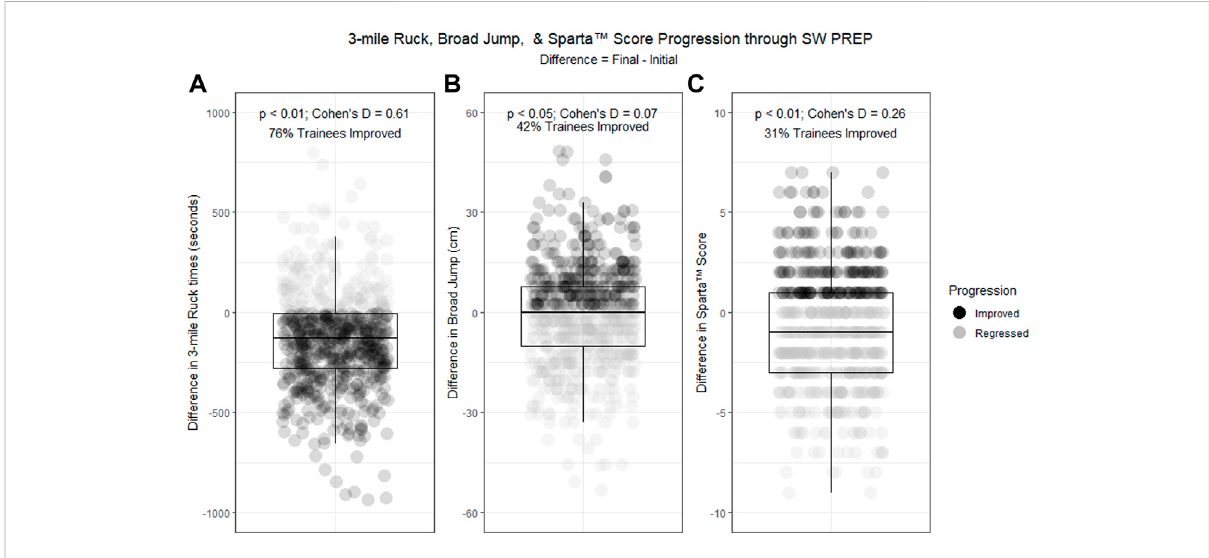
FIGURE 2 Box-and-whisker plots displaying the distribution of differences (Final – Initial) for (A) 3-mile Ruck (seconds), (B) Broad Jump (cm), and (C) Sparta ™ ScoresforSWPreptrainees.Apaired t -testwasusedtocomparemeandifferencesagainstthenull.The p -valueandCohen ’ sDarereported for each paired comparison. Each point represents an individual trainee ’ s measure of difference (Final – Initial) in that event. Trainees who improved their score for that event during SW Prep are colored black, and the proportion of the cohort that improved scores during SW Prep are annotated within each